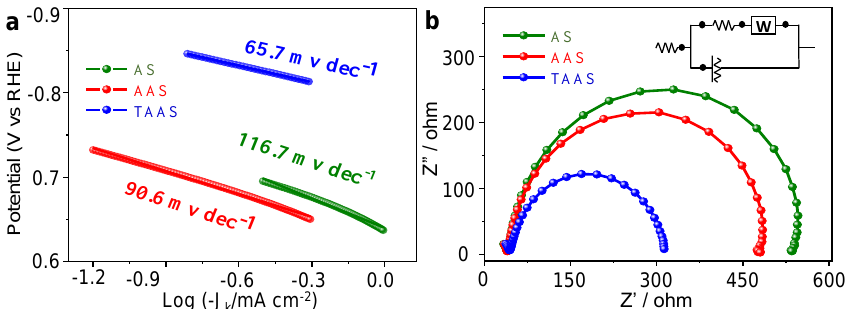
Figure 5. Tafel slope curve spectrum ( a ) and electrochemical impedance (EIS) spectrum ( b ) of AS, AAS and TAAS.